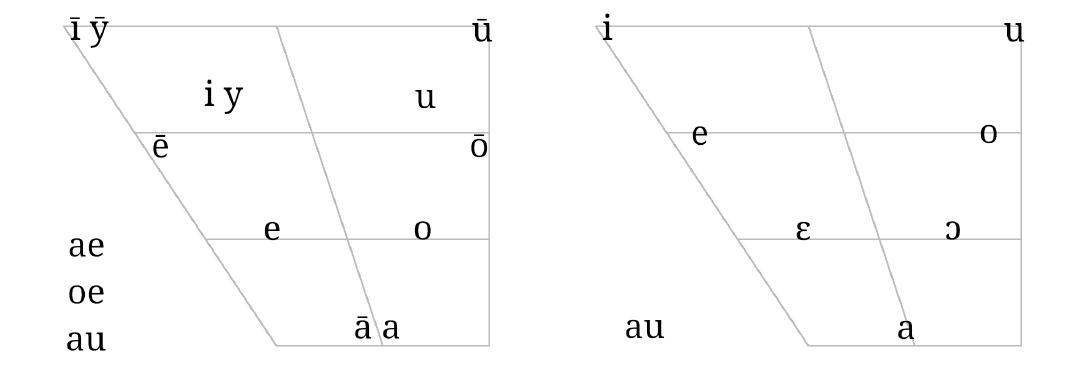
Vowel changes : Classical Latin had twelve phonemic monophthongs, / i y e a o u / with a binary length distinction, and at least³⁴ three phonemic diphthongs, / ae